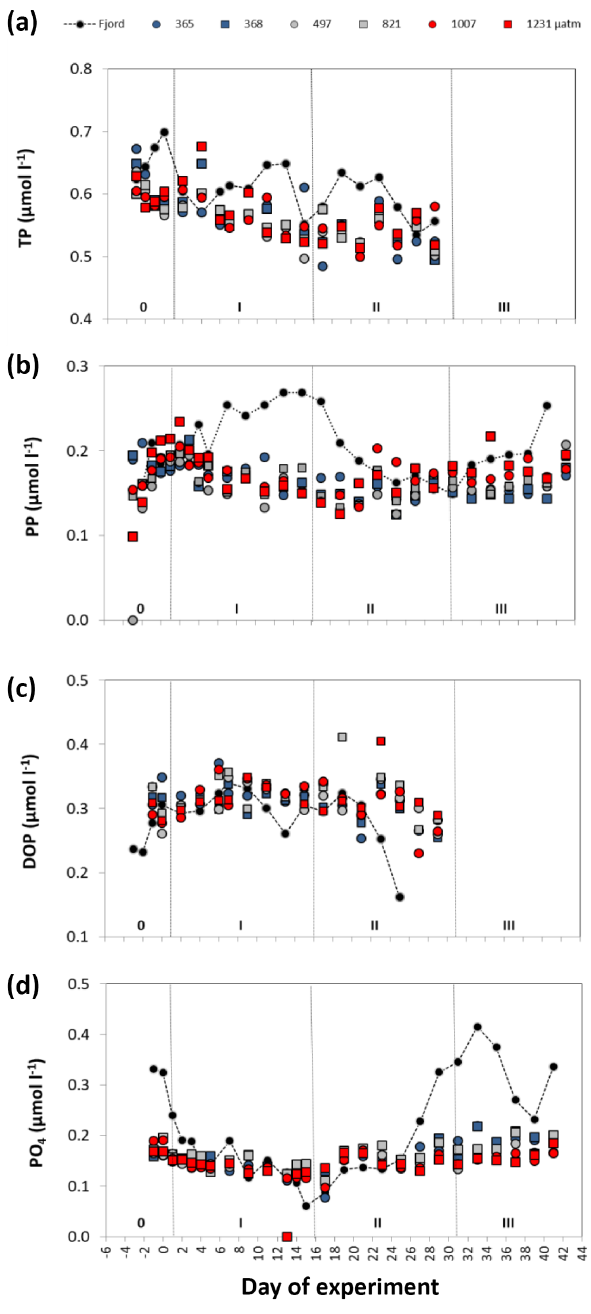
Figure 5. (a–d) Development of total phosphorus (TP) and the three measured P-fractions in fjord water (black dots with dotted line) and in the mesocosms over time. Blue represents untreated, grey intermediate and red high f CO 2 treatment levels.